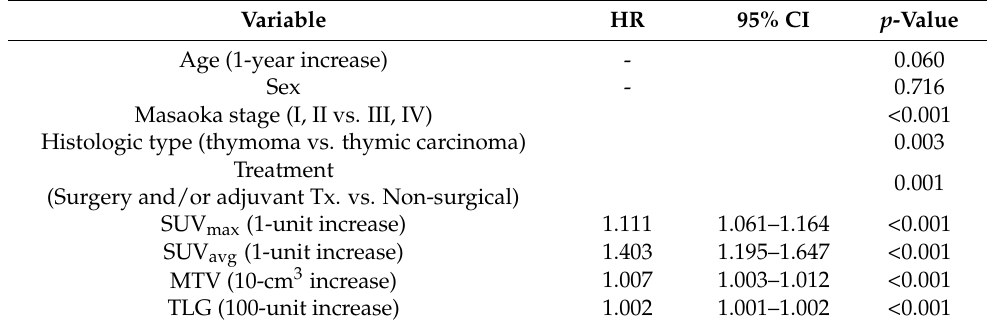
Table 3. Univariate analysis for time-to-progression using Cox proportional-hazard model.